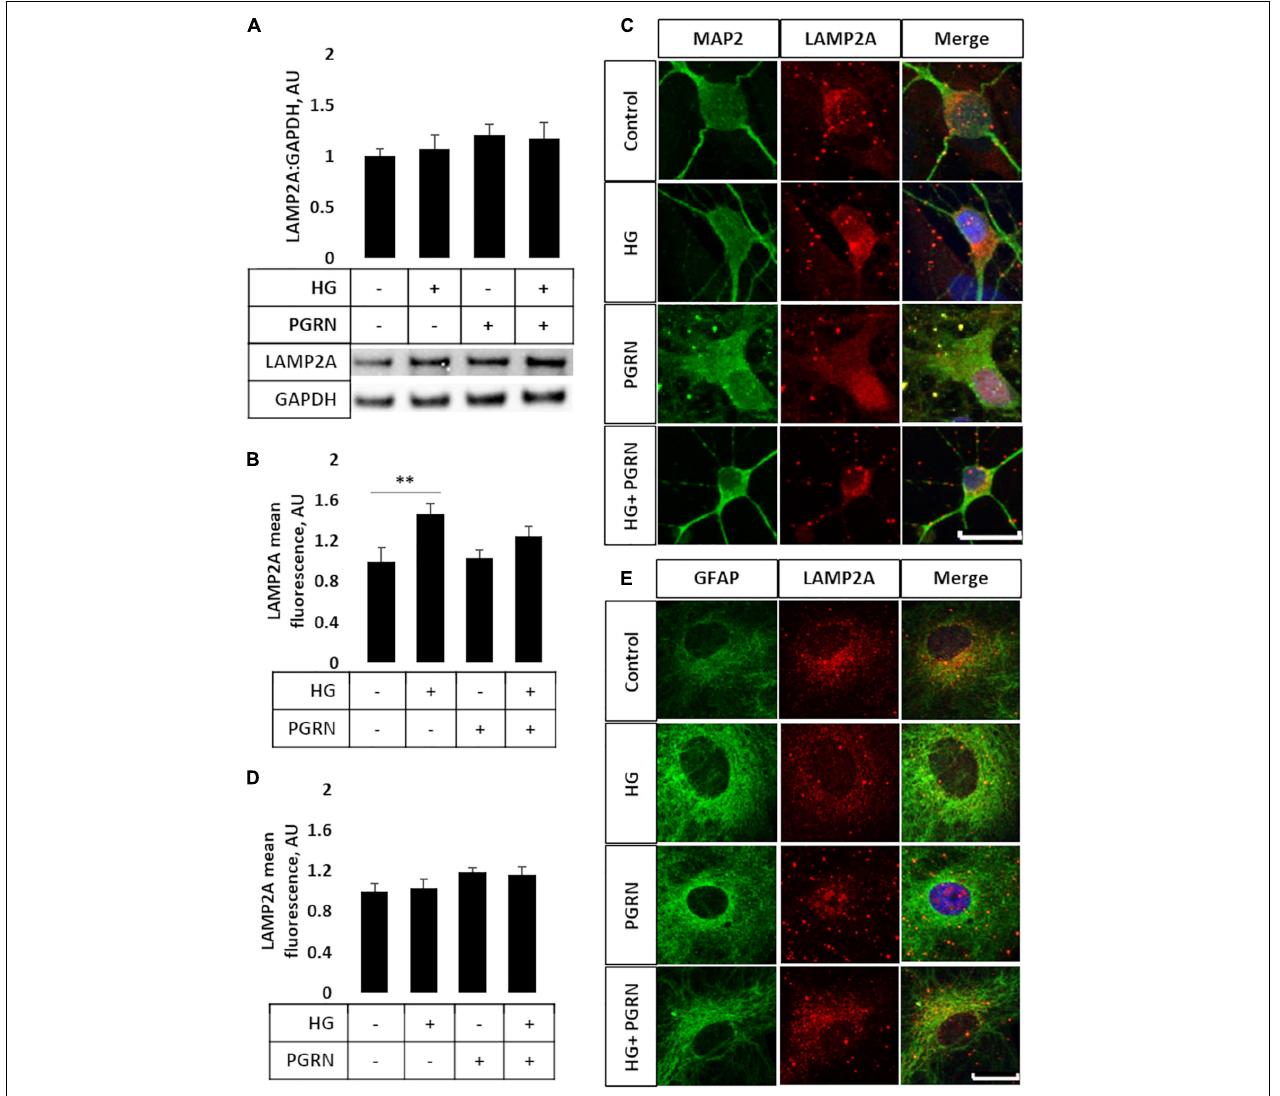
FIGURE 4 | LAMP2A protein levels and punctate localization in cortical neurons and astrocytes due to high glucose and PGRN treatment. (A) Total protein LAMP2A levels are unchanged among treatment groups in primary cortical neurons treated for 24 h. N = 6 samples. (B) Perinuclear LAMP2A punctate formation increased in neurons under HG (from 1.000 ± 0.137 AU to 1.463 ± 0.108 AU), an effect that was attenuated with PGRN (from 1.031 ± 0.083 AU to 1.246 ± 0.096 AU). N = 12-27 cells. (C) Representative immunofluorescence images of primary neurons after 72 h of treatment, with blue as DAPI, green as MAP2, and red as LAMP2A. Scale bar, 10 µ m. (D) Perinuclear LAMP2A punctate formation appeared to show a trend toward an increase due to PGRN but was not statistically significant ( F = 1.825, p = 0.151). N = 16-22 cells. (E) Representative immunofluorescence images of primary astrocytes after 72 h of treatment, with blue as DAPI, green as GFAP, and red as LAMP2A. Scale bar, 10 µ m. ∗∗ p <